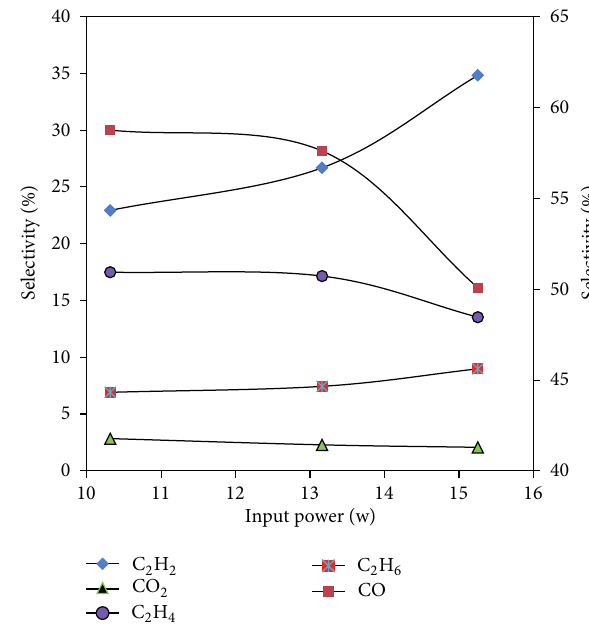
F 4: Selectivity of products versus input power to the reactor in corona discharge plasma.